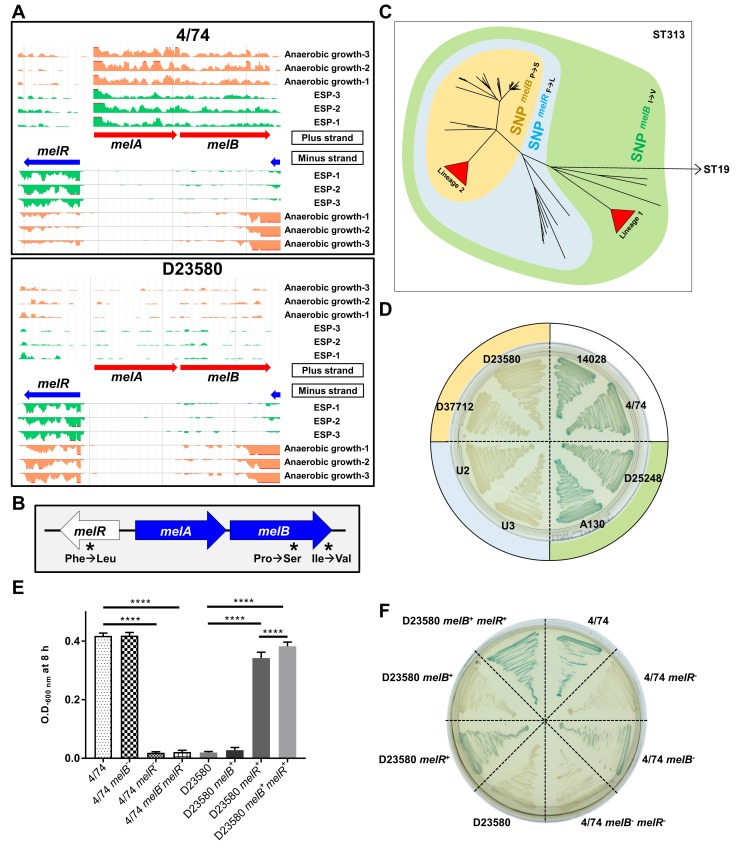
Melibiose phenotype differentiates the S. Typhimurium ST19 and ST313 strains.(A) Visualization of RNA-seq data with three biological replicates in the ESP and anaerobic growth conditions using JBrowse [52] for the melibiose utilization operon. The scale of the mapped reads was 1 to 100. (B) Presence of three nonsynonymous SNPs in the melibiose utilization genes (4/74 → D23580). (C) Accumulation of SNPs in the melibiose utilization genes during the evolution of ST313 in the context of a whole-genome-core SNP phylogeny. Isolate names, ST313 lineage, and genotype for the three SNPs are included in S8 Table. (D) Alpha-galactosidase activity of representatives of ST19 and ST313 strains on Pinnacle Salmonella ABC medium (Lab M, Heywood, UK); green = positive, colorless = negative. The colors of the external circle correlate with the colors represented in the tree in (C). (E) Bacterial growth in minimal M9 medium supplemented with 0.4% melibiose (S1 Data). Statistical analysis was performed using one-way ANOVA and Tukey’s multiple comparison test. Bars represent the mean of seven biological replicates and standard deviation. Significant differences (****) indicate p-value <0.0001. (F) Alpha-galactosidase activity of 4/74 and D23580 WT strains and corresponding mutants. The ability to use melibiose is rescued in D23580 by exchange of the three SNP mutations. ESP, early stationary phase; RNA-seq, RNA sequencing; SNP, single-nucleotide polymorphism; ST, sequence type; WT, wild type.